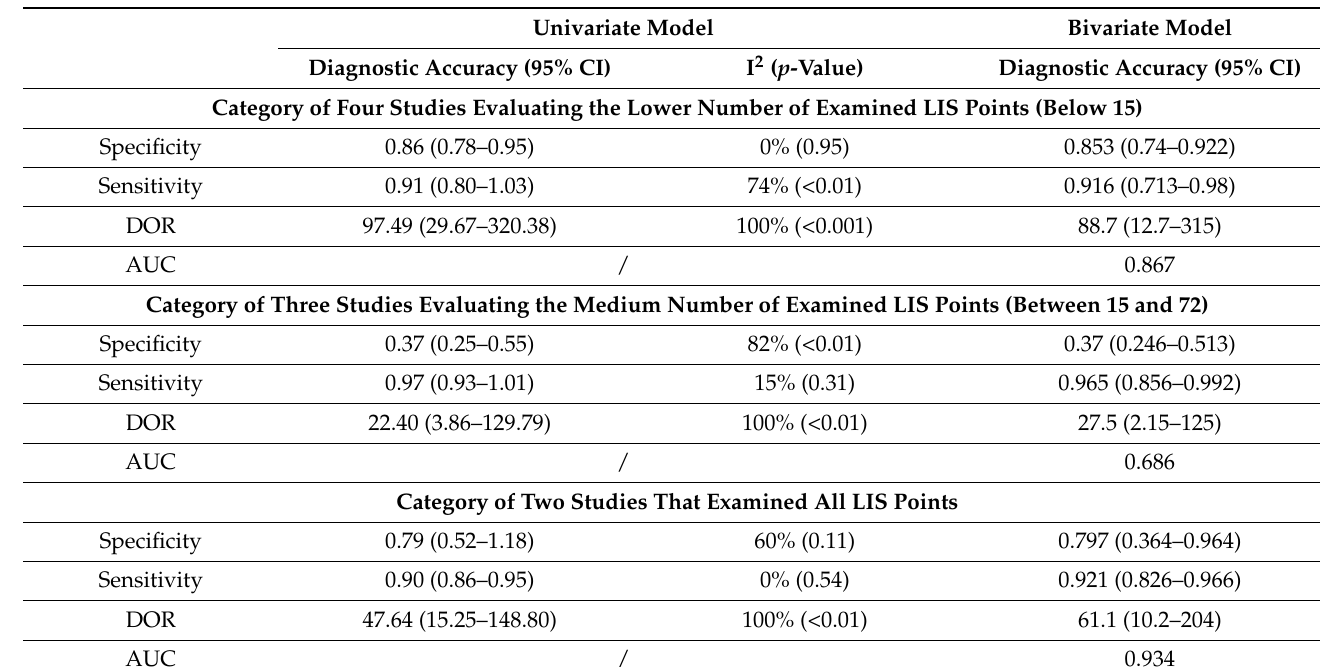
Table 3. Meta-analysis of three LIS subgroups